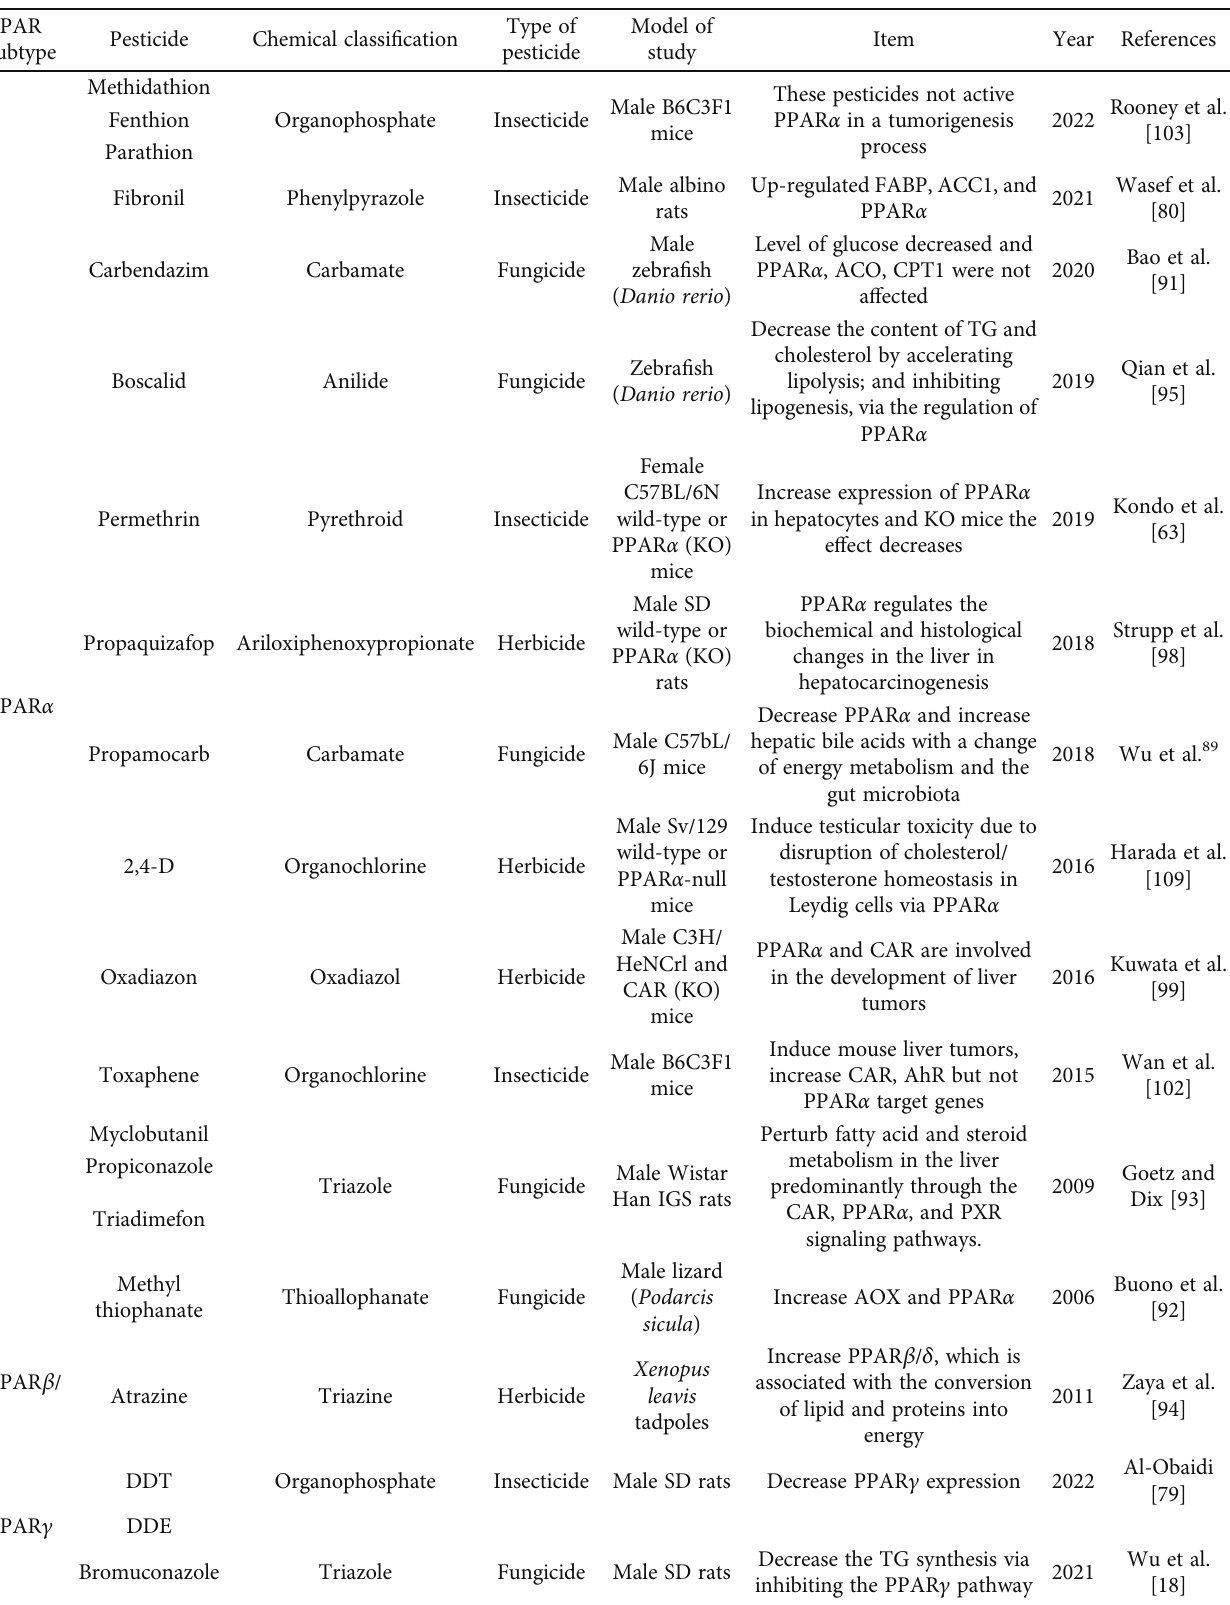
Table 3: In vivo models of pesticide e ff ect above the PPAR